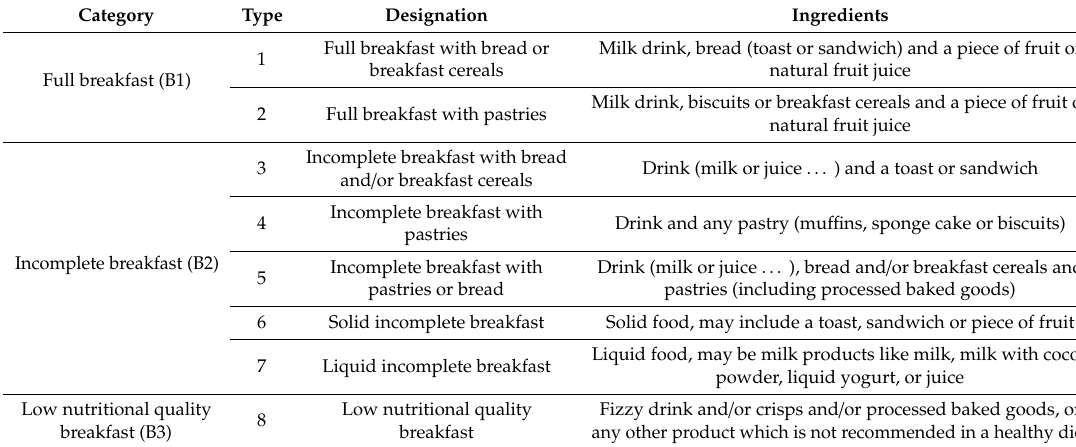
Table 1. Type of